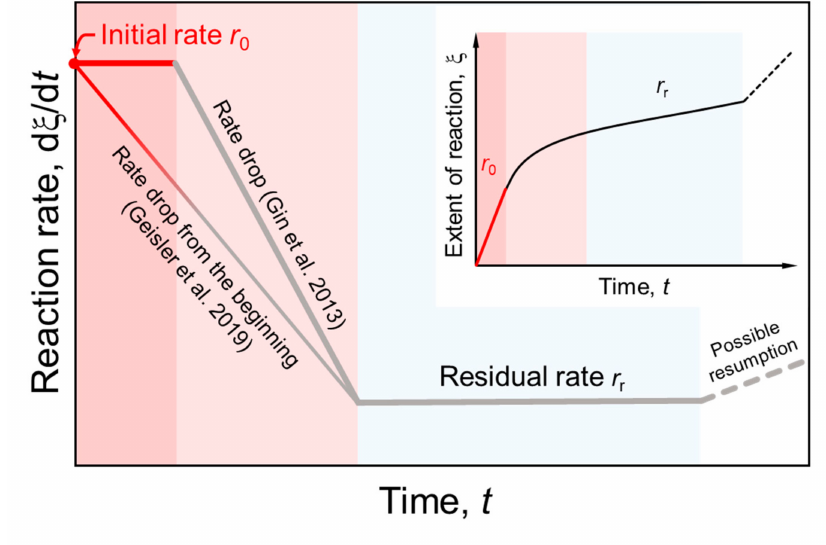
Figure 1. Kinetic regimes of glass corrosion that have been identified to date [2], illustrated by a plot of the reaction rate and the extent of reaction, ξ (inset diagram), as a function of time. Here, ξ represents the amount of glass dissolved into solution or transformed into a silica-based surface layer (SAL). In the present work, we are mainly concerned with the initial reaction rate, r 0 , that represents the forward dissolution rate of the glass. Gin and coworkers [2] proposed a constant r 0 for a certain time until an SAL is formed. In contrast, Geisler et al. [21] recently observed a linearly decreasing r 0 over time already from the beginning of the reaction without the formation of an